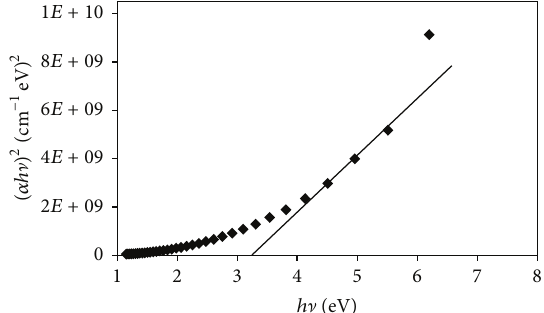
Figure 8: Plot of (𝛼ℎ ] ) 2 versus ℎ ] of Al 2 O 3 ⋅ CaO nanocatalysts.